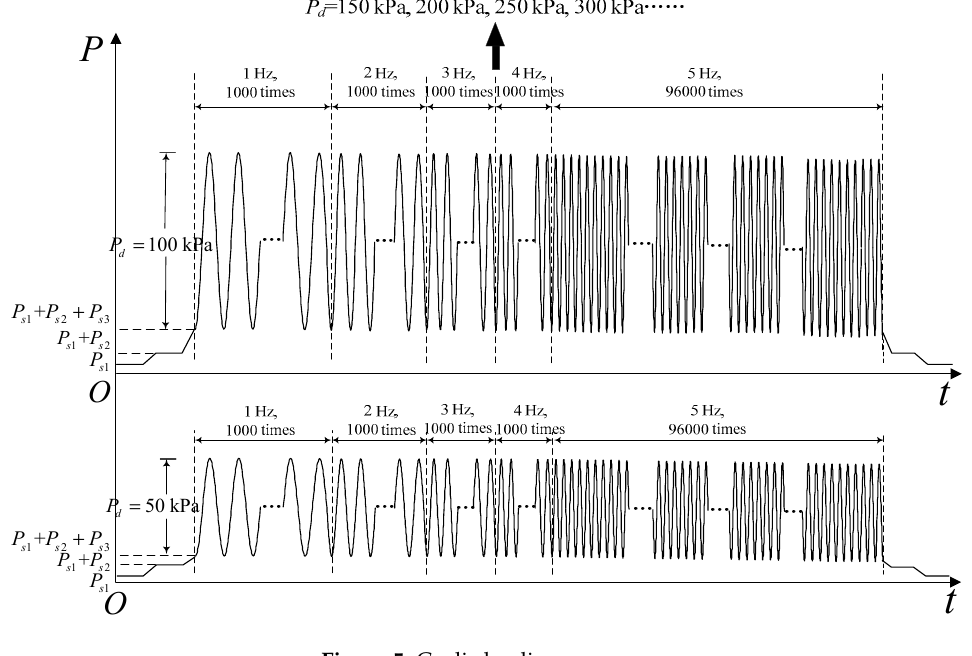
Figure 5. Cyclic loading program. 234